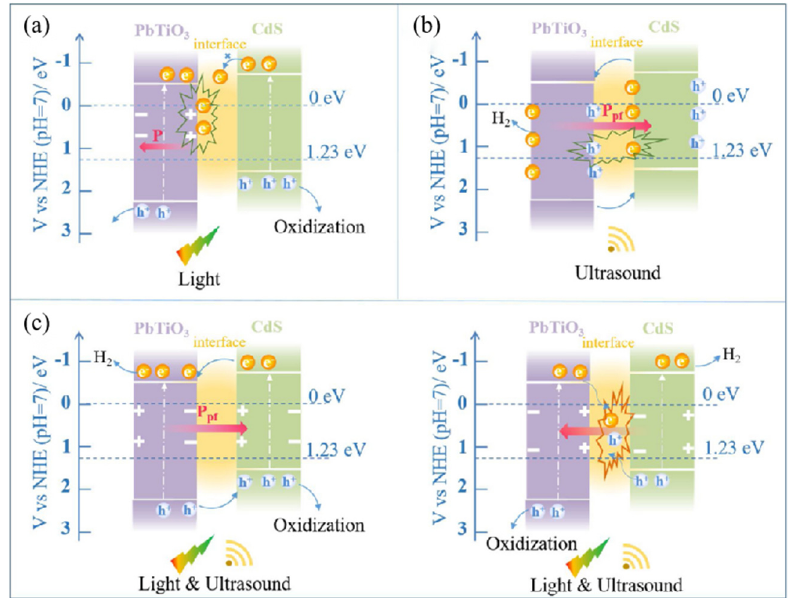
Figure 18. Schematic diagram of ( a ) photocatalysis, ( b ) piezocatalysis, and ( c ) piezo-photocatalysis for PbTiO 3 /CdS composites (Reprinted/adapted with permission from Ref. [183]. Copyright 2021, copyright